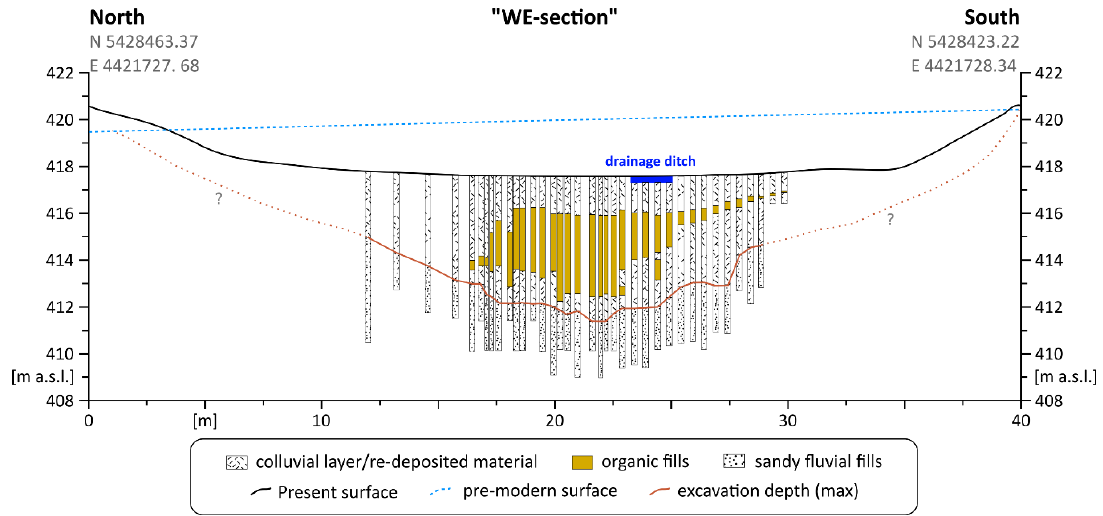
Figure 6. Cross-section reference geometry based on direct push sensing. The sketch of the “WE cross-section” transect shows present and pre-modern surface levels, trench geometries and maximum excavation depth.